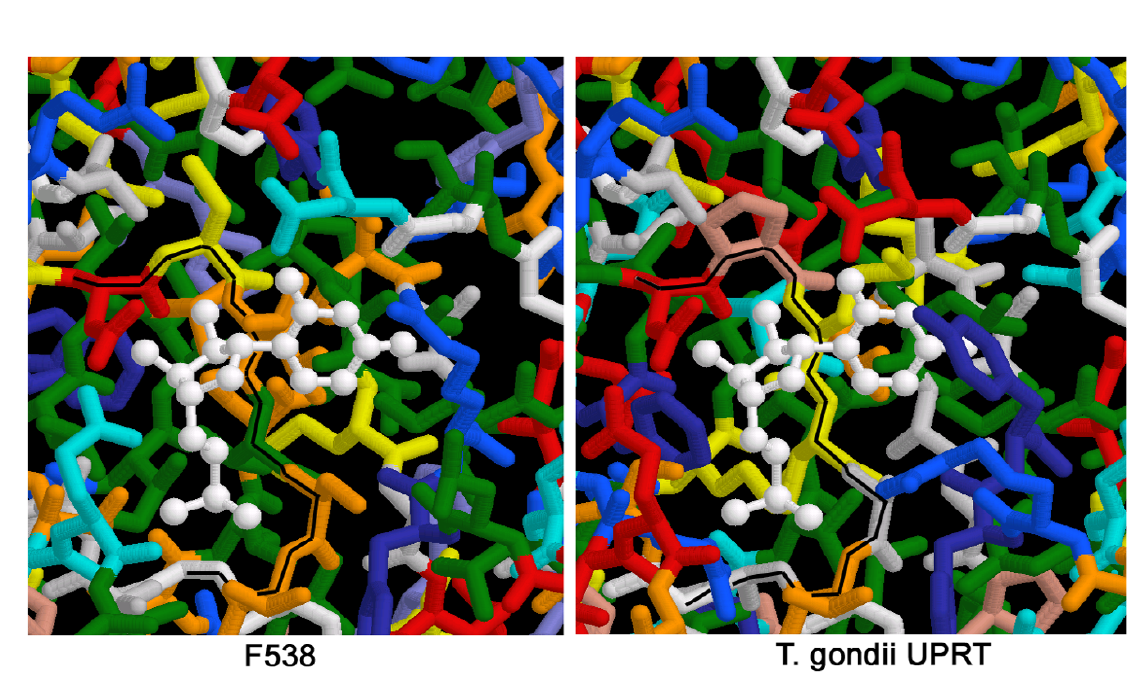
Figure 9 The structure of T. gondii UPRT active center with coordinated UMP (white balls and sticks) as compared to the predicted SWISSModel structure of F538. The UPRT conserved region III that shows the highest difference between the two proteins still exhibits the same folding pattern (black line on the